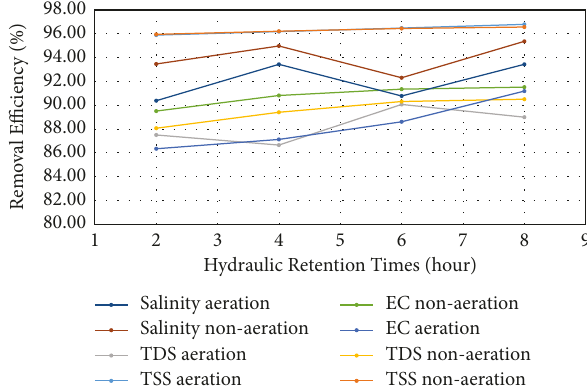
Figure 4: The removal efficiencies of BOD, COD, TKN, and FOG in aeration and nonaeration HSFCWs